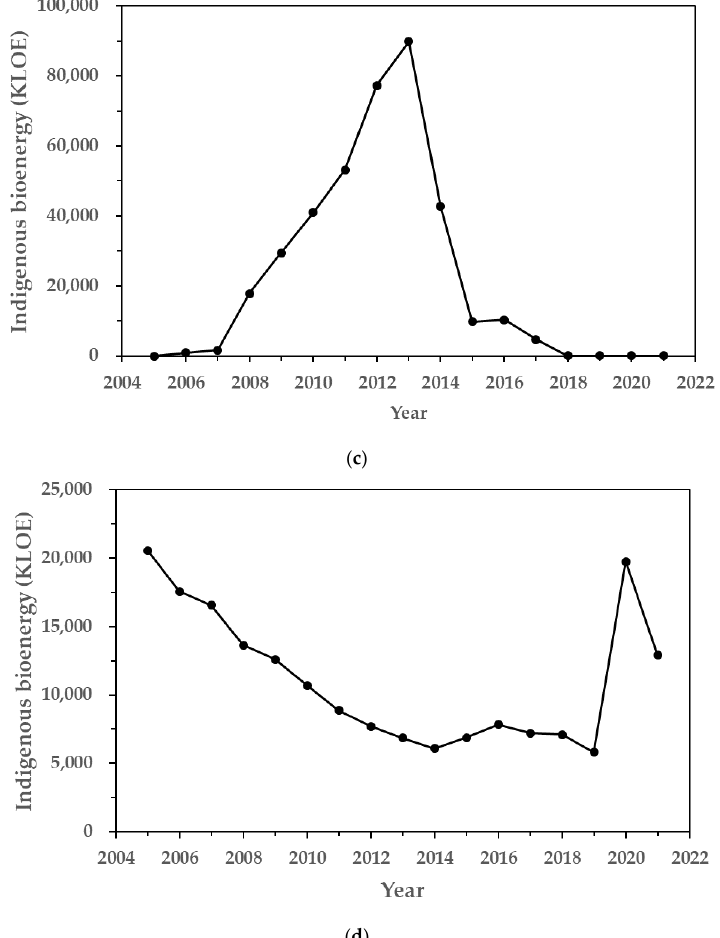
Figure 2. Variations in energy supply from ( a ) indigenous bioenergy, ( b ) indigenous solid-type bioenergy, ( c ) indigenous liquid-type bioenergy, and ( d ) indigenous gas-type bioenergy [7].